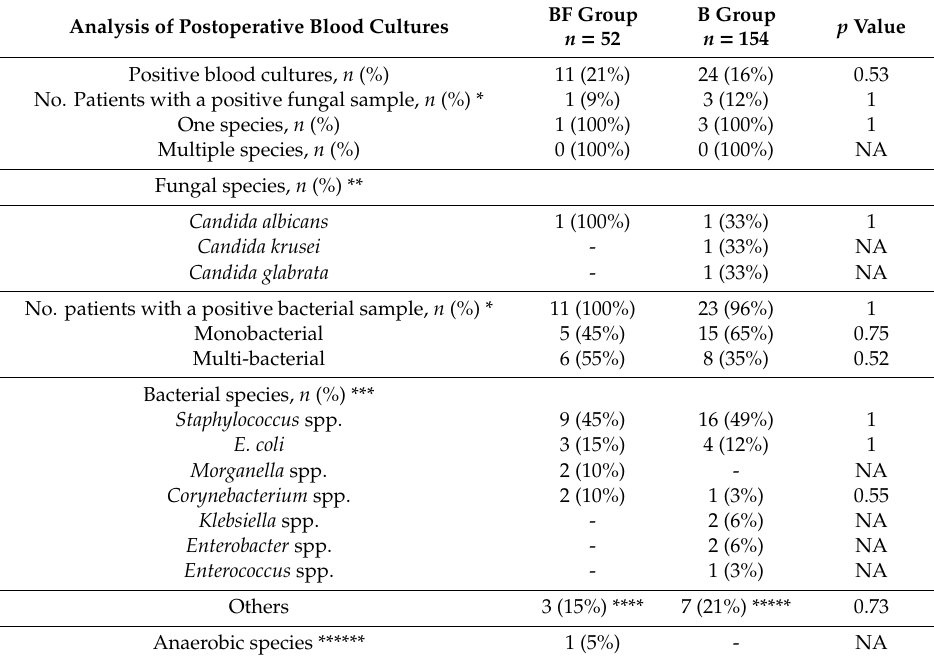
Table 4. Analysis of postoperative blood cultures.